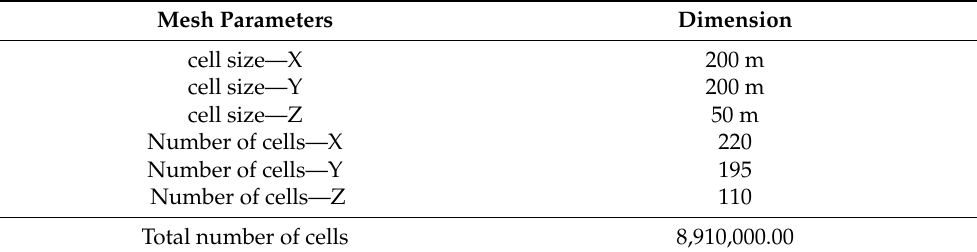
Table 3. Mesh used in the BFG inversions of the MR3D time lapse. Mesh